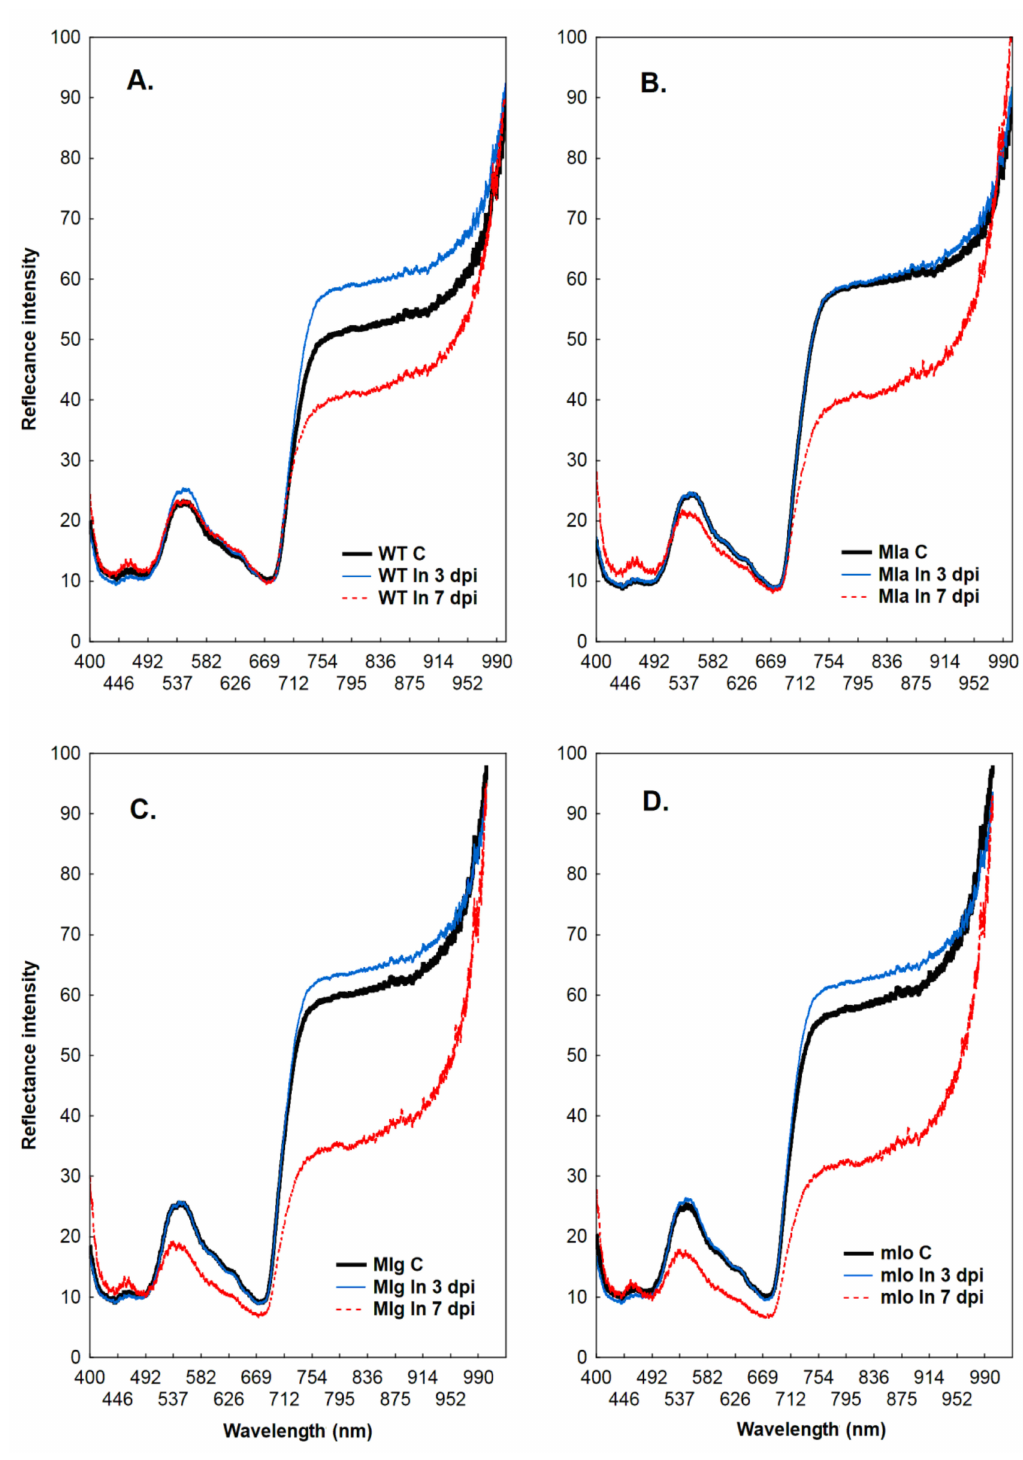
Figure 2. Reflectance intensity of barley leaves of the wild type cultivar Ingrid (panel A ) and its near-isogenic lines Mla ( B ), Mlg ( C ), and mlo ( D ). Abbreviations: WT, wild type Ingrid; C, control leaves; In, leaves inoculated with powdery mildew: 3 dpi or 7 dpi (leaves 3 and 7 days post inoculation with powdery mildew). Each curve represents the average of measurements made on 10 plants. Since the reflectance values of not inoculated control leaves were similar at time points corresponding to 3 and 7 dpi they were summed up and shown as one